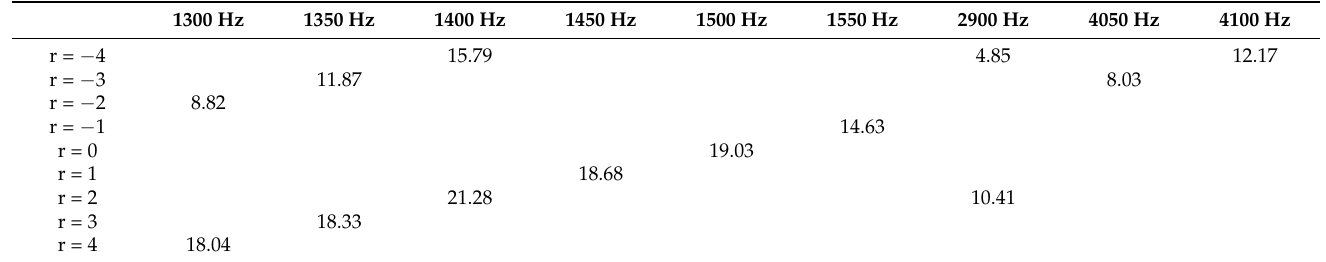
Table A3. Frequency, order and amplitude of electromagnetic force wave under 30% dynamic eccentricity operating conditions (1300–4100 Hz).